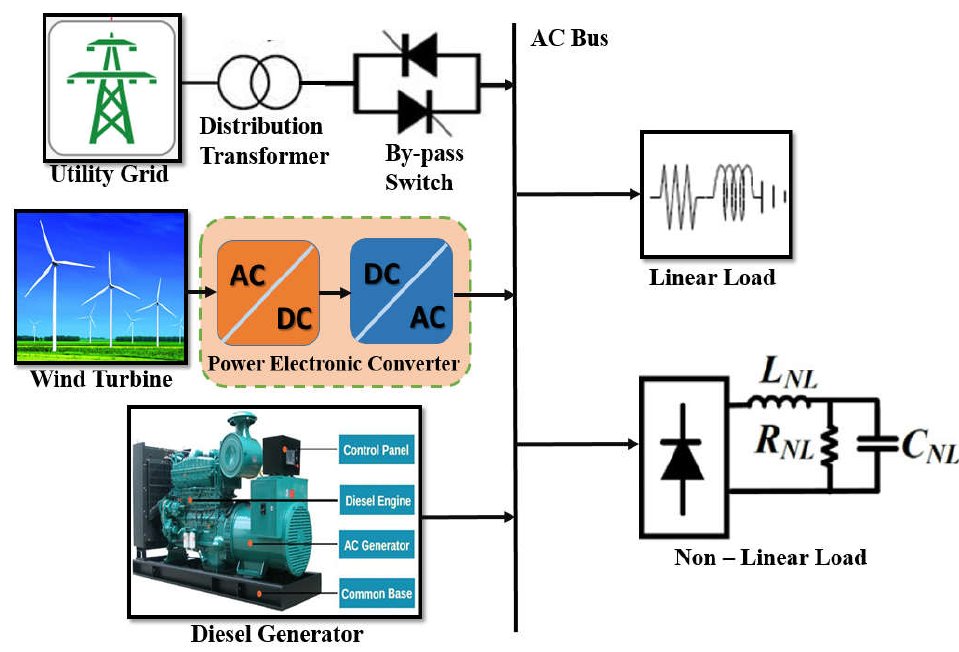
Figure 3. Circuit of AC MG. Table 5. Optimization methods in AC MG.